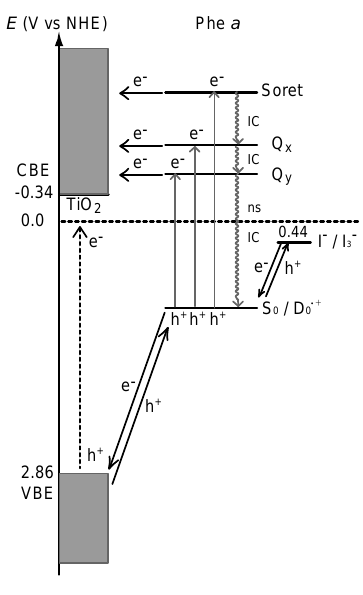
Figure 36. A mechanism of parallel electron transfer, i.e. , one, via the singlet-excited states and the other, via the ground redox states.